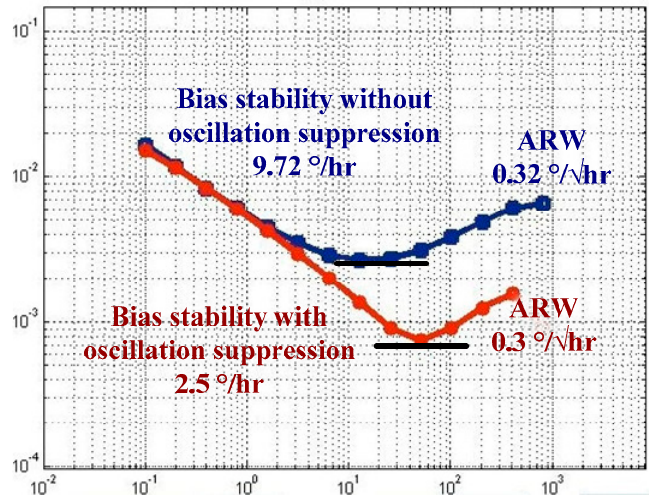
Figure 15. Allan variance curve with and without oscillation suppression.